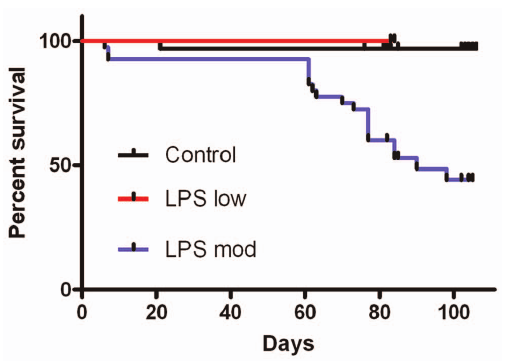
Figure 1. Survival with weekly injections of saline or LPS. Mice were injected weekly with i.p. saline (control, n=32), LPS low dose (0.1– 1.0 mg/kg, n=16), or LPS moderate (mod) dose (10–20 mg/kg, n=40). There were significant differences in survival between groups (P , 0.0001). Survival decreased with moderate dose LPS compared with low dose LPS (P=0.003) or saline (P , 0.0001). Survival did not differ with low dose LPS compared with saline.